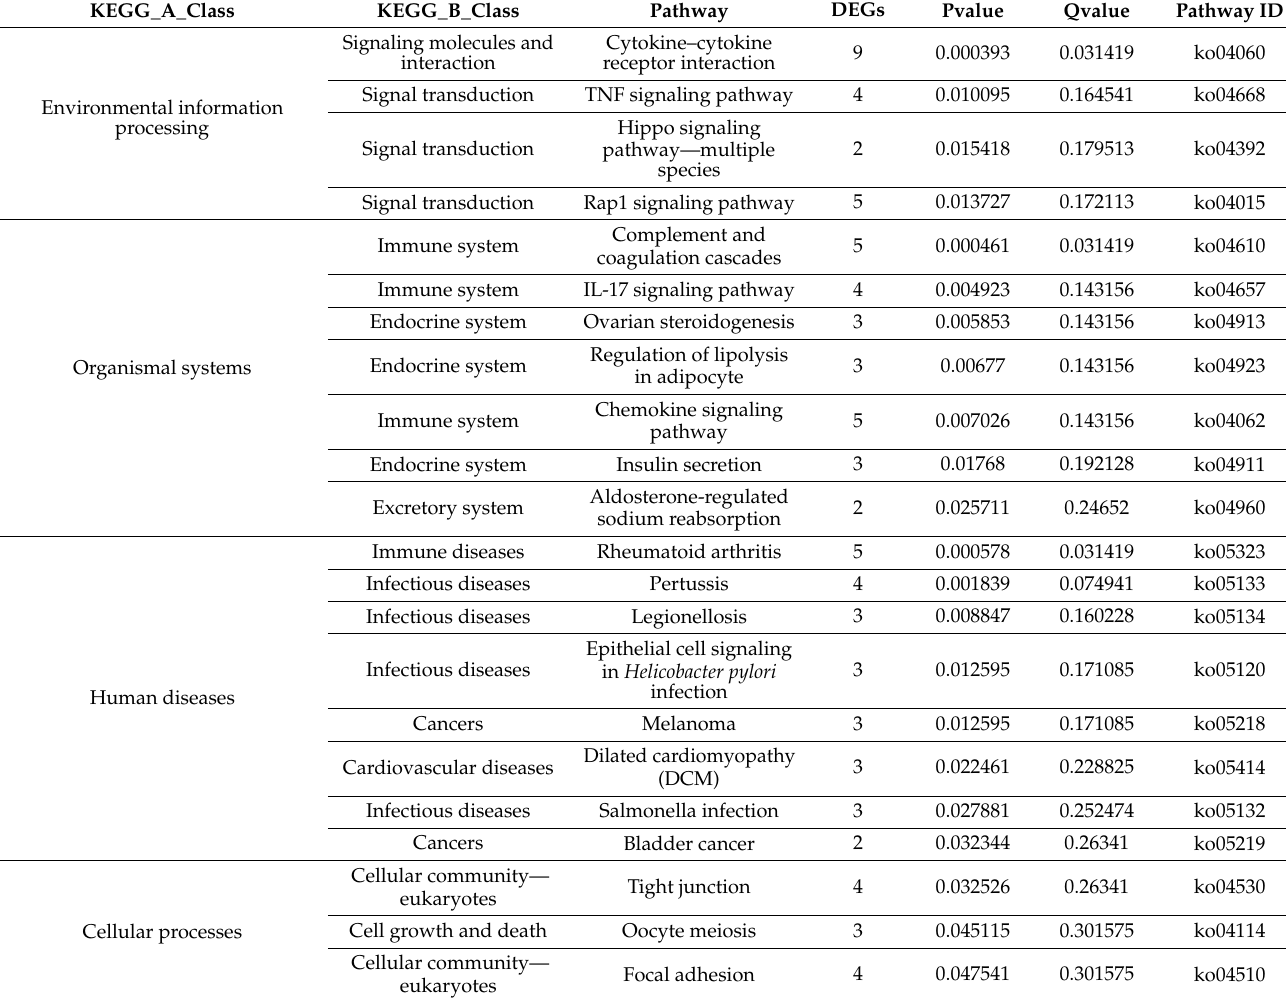
Table 1. Description of KEGG pathways classes altered by DEGs in bovine adipocytes transfected with bta-miR-149-5p mimics or mimics